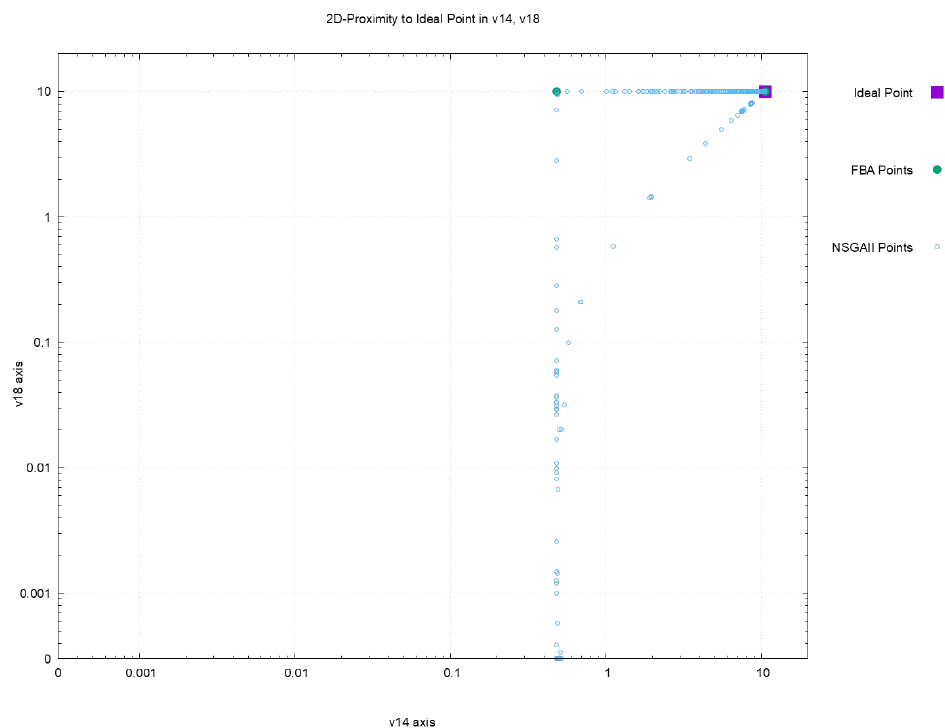
Figure 5. Pareto approximation for configuration C 0 with respect to the plane formed by objectives ( v ) 14 , v 18